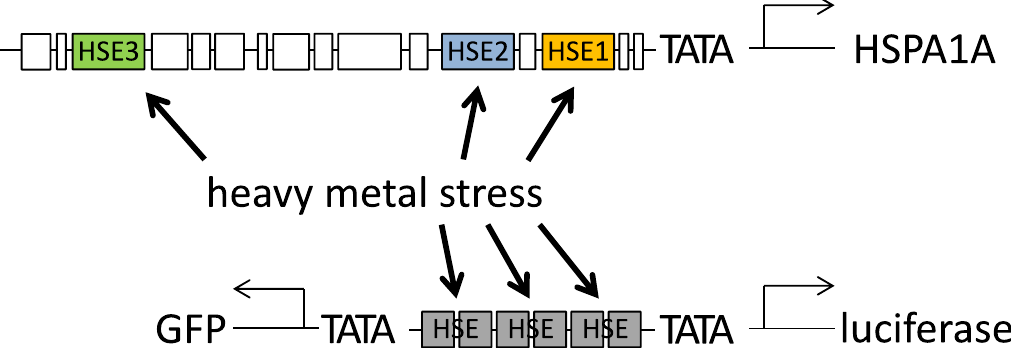
Fig 6. Activation of HSEs by heavy metals stress. Heavy metal stress acts on the heat shock pathway by activating HSF1 which interacts with the HSEs of target genes. Of key importance in this respect are affinity and position of the HSEs within the target promoter. Consensus HSEs were used to generate a high sensitivity reporter construct for detection of heavy